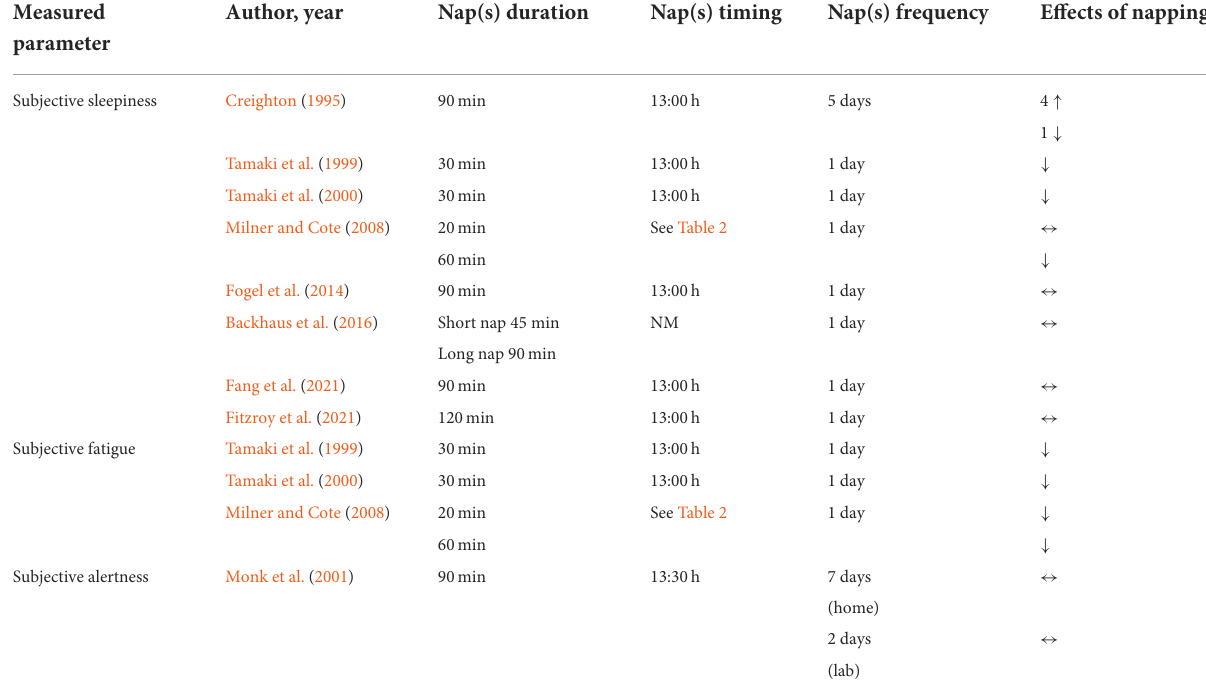
TABLE 4 The effects of napping on perceptual